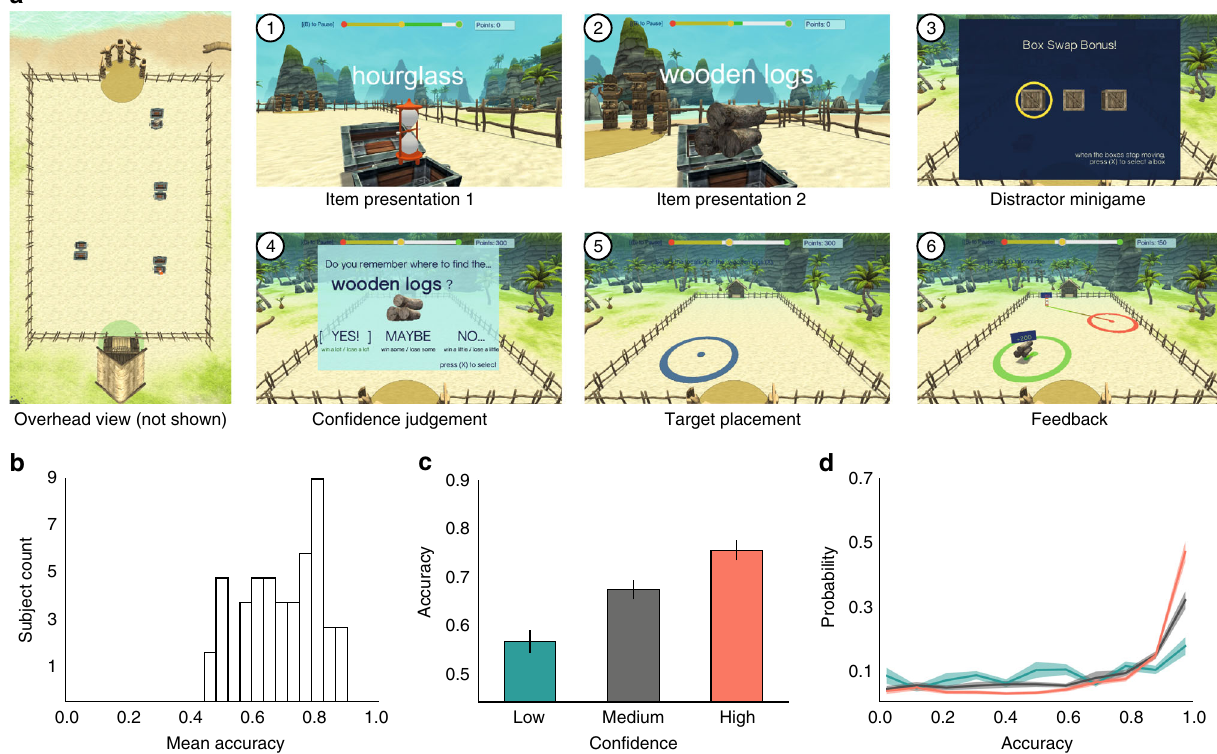
Fig. 1 Task methods and behavior. a Screen shots of an example trial in the Treasure Hunt task. The top left image shows an overhead view of the environment with chest positions visible. This view is never shown to subjects, and only one chest is visible at a time during the actual trial. Panels 1 – 6: representative epochs of a single trial, showing 1) fi rst item presentation, 2) second item presentation, 3) the distractor period before the retrieval period, 4) the con fi dence judgement, 5) responding by indicating an item ’ s remembered location, and 6) feedback. Treasure Hunt was created using the Unity 3D graphics engine. b Histogram of mean subject accuracy ( N = 50). c Mean accuracy as a function of subjective con fi dence. Error bars are ±1 SEM. d Probability of a given response as a function of accuracy, calculated independently for each con fi dence level. Error bars are ±1